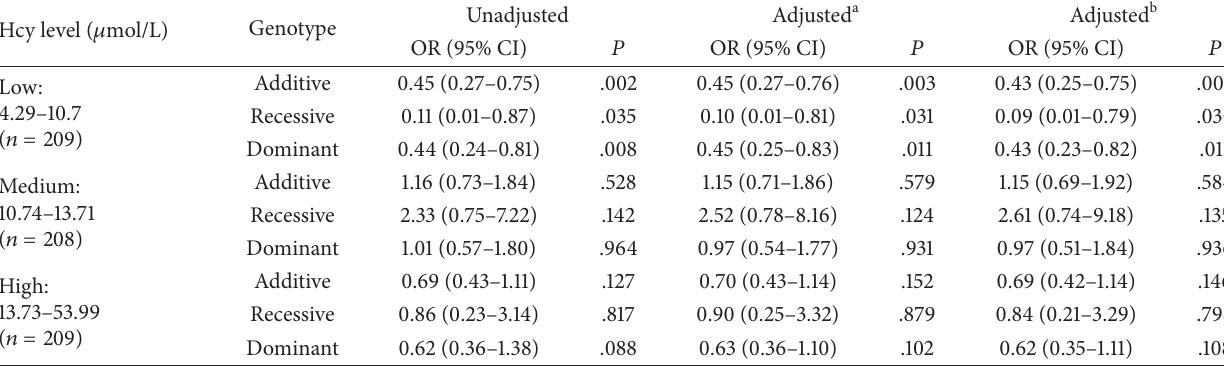
Table 5: Association of EPHX2 G860A with risk of ischemic stroke in different Hcy level groups.